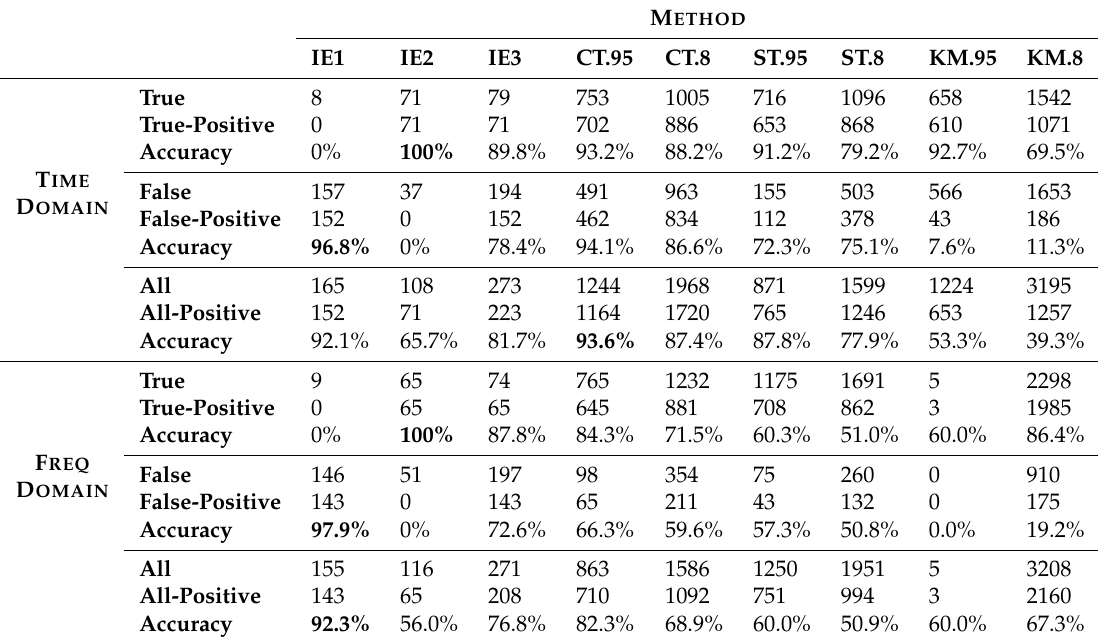
Table 3. Comparison of pseudo-labeling algorithms performing on S 2.1